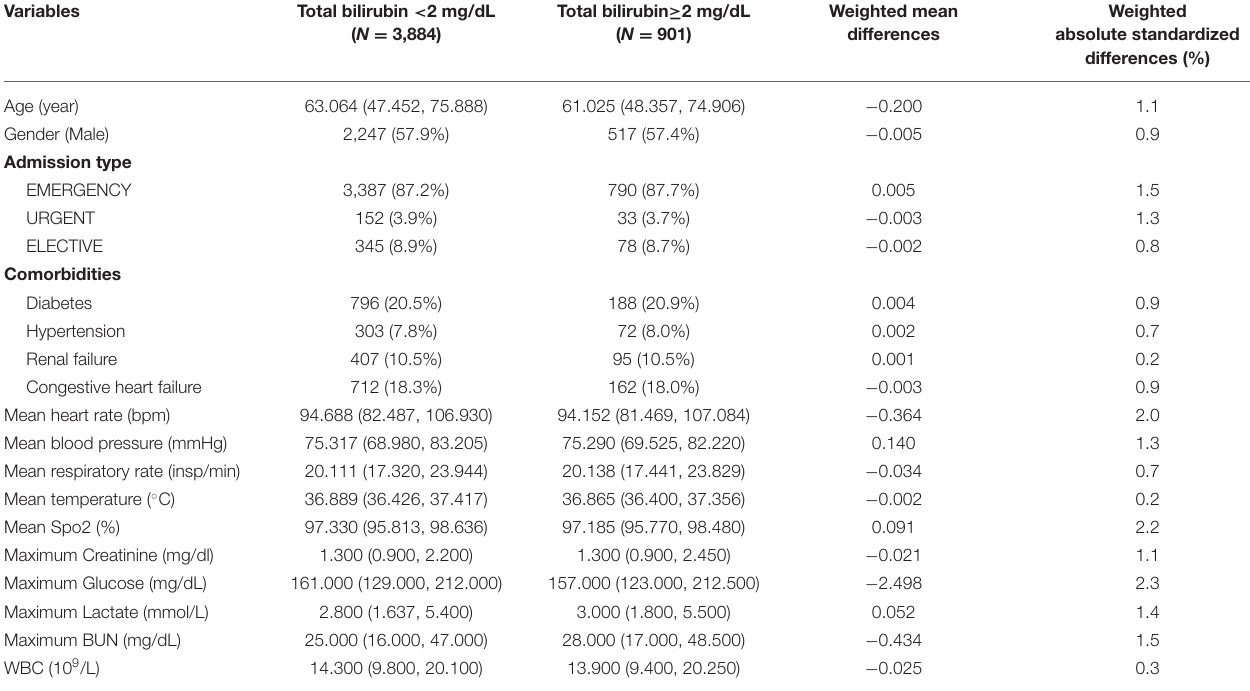
TABLE 4 | Balance checking for the variables after propensity score